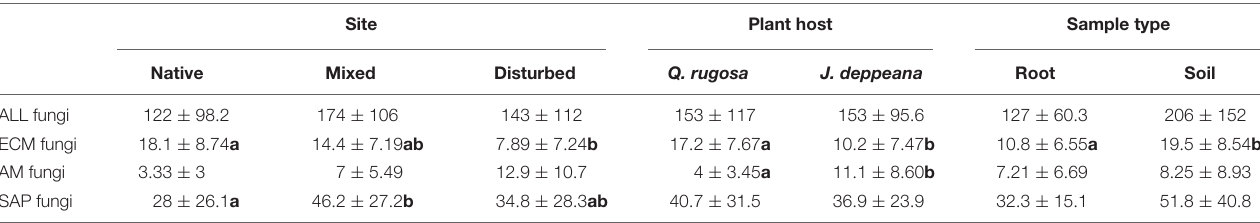
TABLE 2 | Mean and standard deviation of observed richness (number of OTUs) per sample between sites (native, mixed, disturbed), plant hosts ( Juniperus deppeana , Quercus rugosa ) and sample type (root, soil) based on non-parametric Kruskal–Wallis tests and pairwise Mann–Whitney U -tests, with significant values ( P ≤ 0.05) indicated with bold